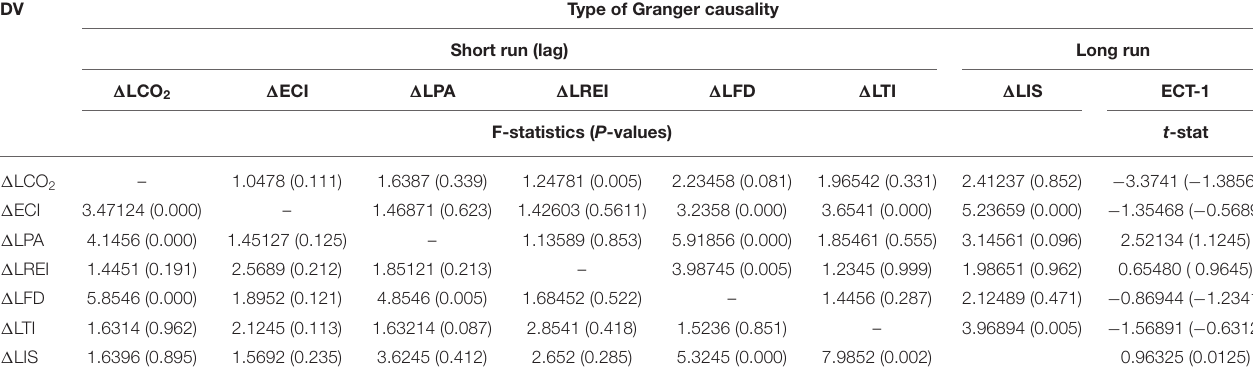
TABLE 9 | Granger causality